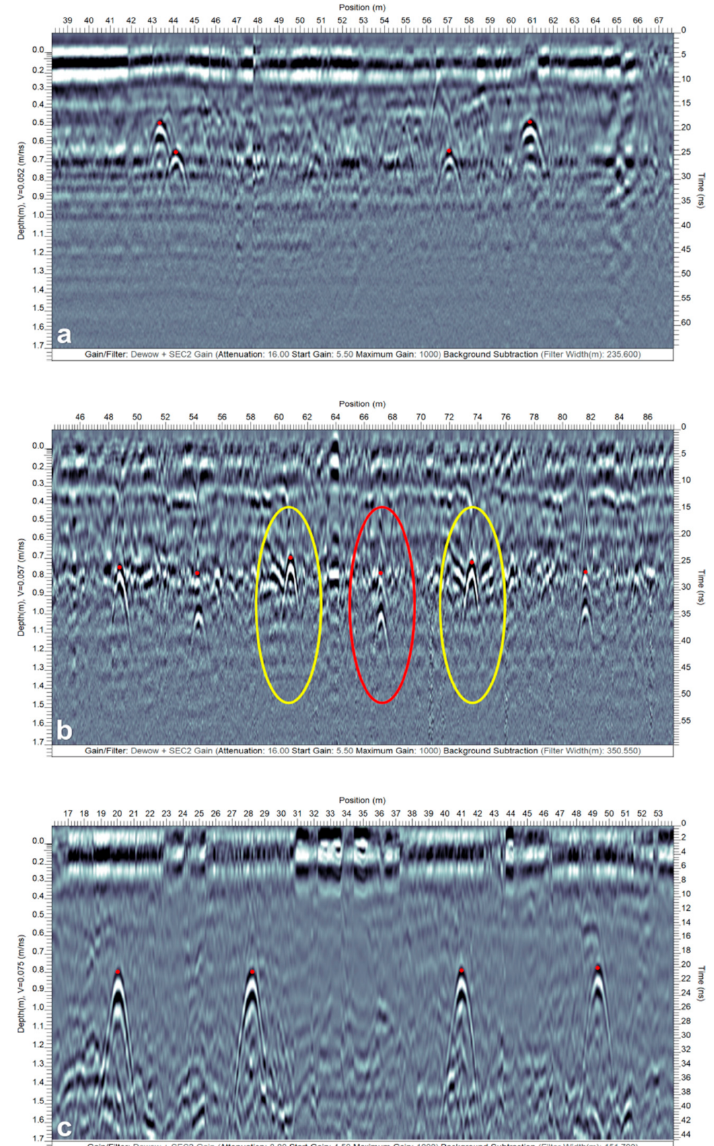
Figure 14. Drainage pipe response on the GPR vertical profile depicting closely spaced hyperbolic features from two different depths at: ( a ) Site-4 (from Region-2 of Figure 15d), potentially caused due to drainage pipes from different generations of installations, ( b ) Site-1 (from Region-1 of Figure 15a), caused due to the same drainage pipe probably with undrained water, but the first hyperbolic response being very weak in some instances obscures its visibility. Note that the latter profile can potentially be misinterpreted as a response caused due to two co-existing drainage pipes at different depths. ( c ) depicts the drainage pipe response from Site-3 (from Region-2 of Figure 15c). Here, the closely spaced hyperbolic features at a similar depth are caused due to the spiral and serpentine transects